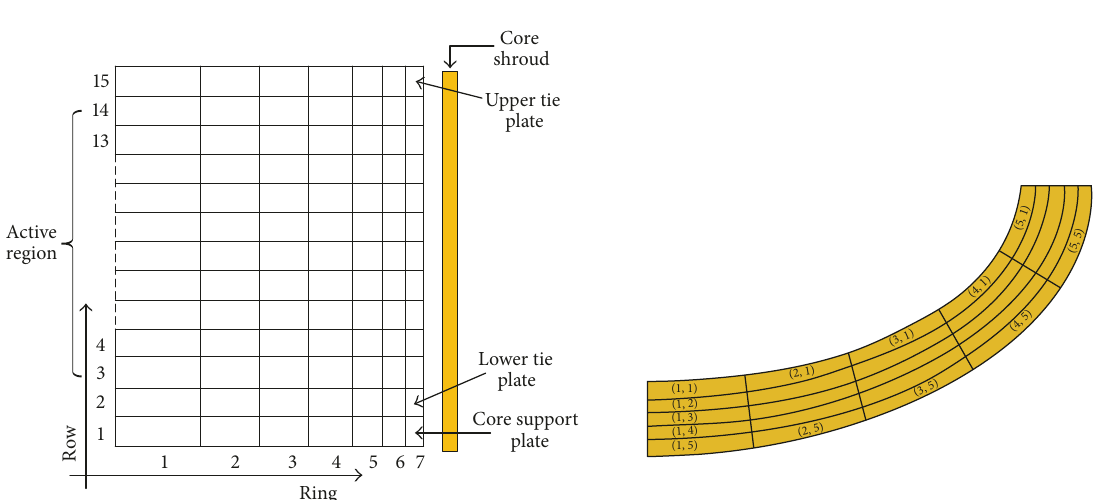
Figure 1: Primary system nodalization.